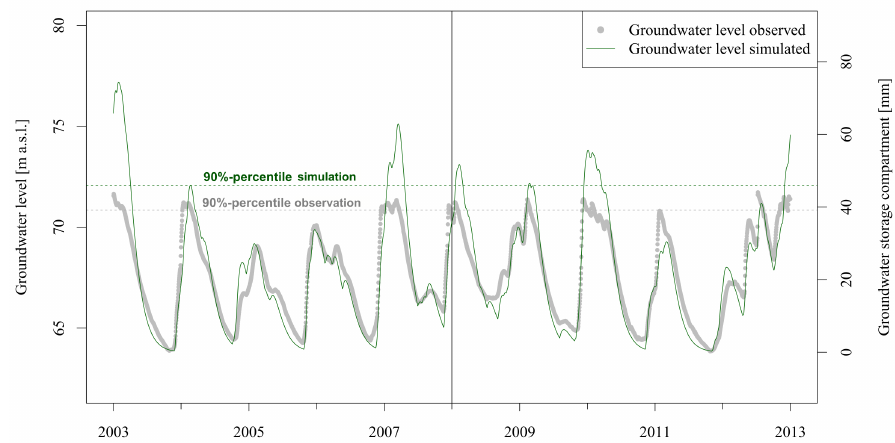
Figure 6. Illustration of the percentile approach. Time series of the observed (grey dots) and modelled (green line) groundwater levels at Ashton Farm. The dotted lines represent the respective 90th percentile. Table 3. Deviations of simulated to observed exceedances of different percentiles in the validation period (borehole: Ashton Farm). The left value is the mean absolute deviation MAD (d), the right value is the deviation percentage PAD